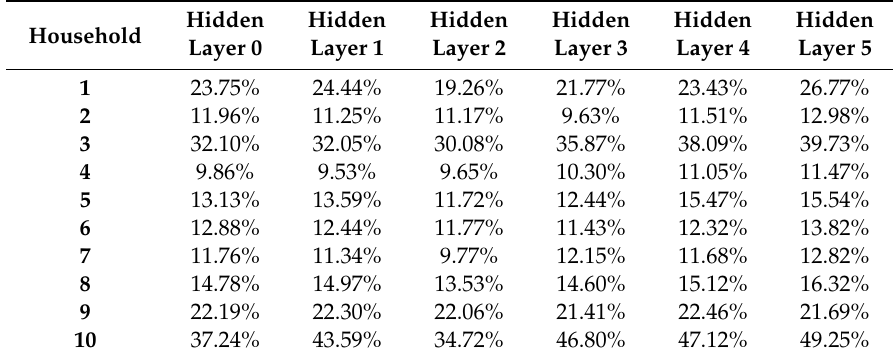
Table 2. Load Forecasting results (mean absolute percentage error (MAPE)) with a number of di ff erent hidden